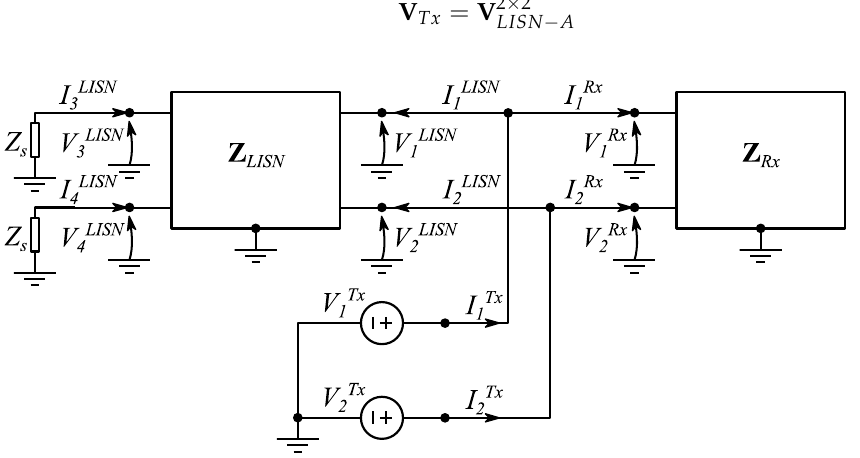
Figure 15. Calculation of PLC Tx equivalent voltage sources.